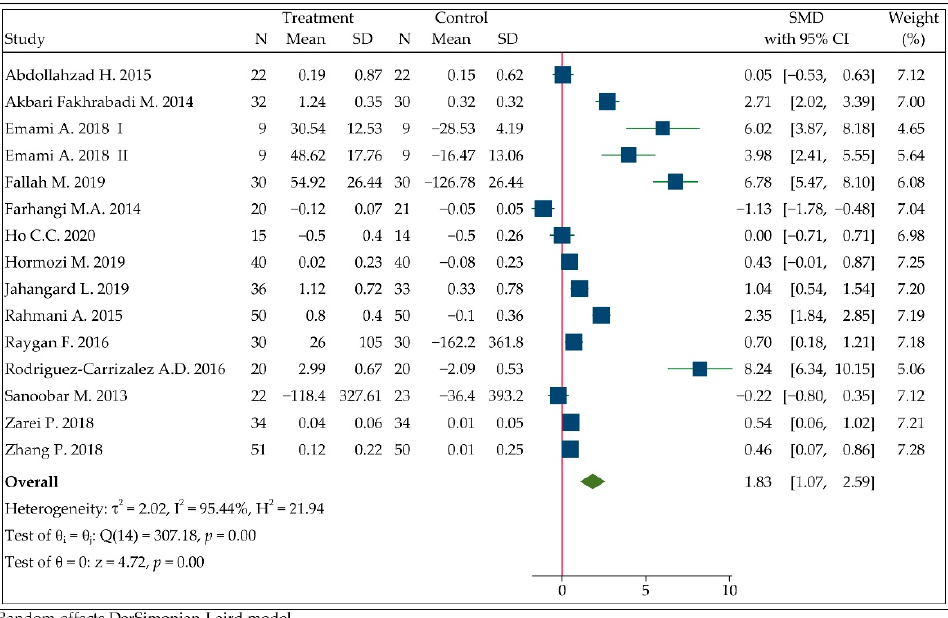
Figure 2. Forest plot of the meta-analysis on the effect of CoQ10 supplementation on net changes of TAC.